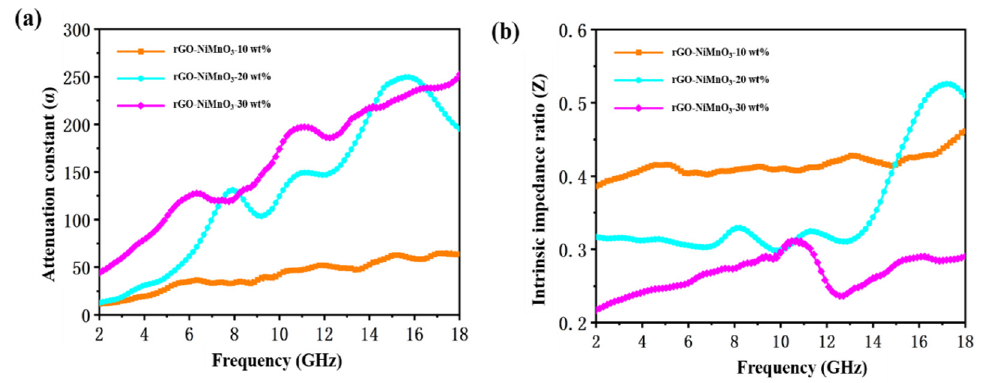
Figure 5. Attenuation constant ( a ) and impedance matching ratio ( b ) of rGO-NiMnO 3 with different doping levels.